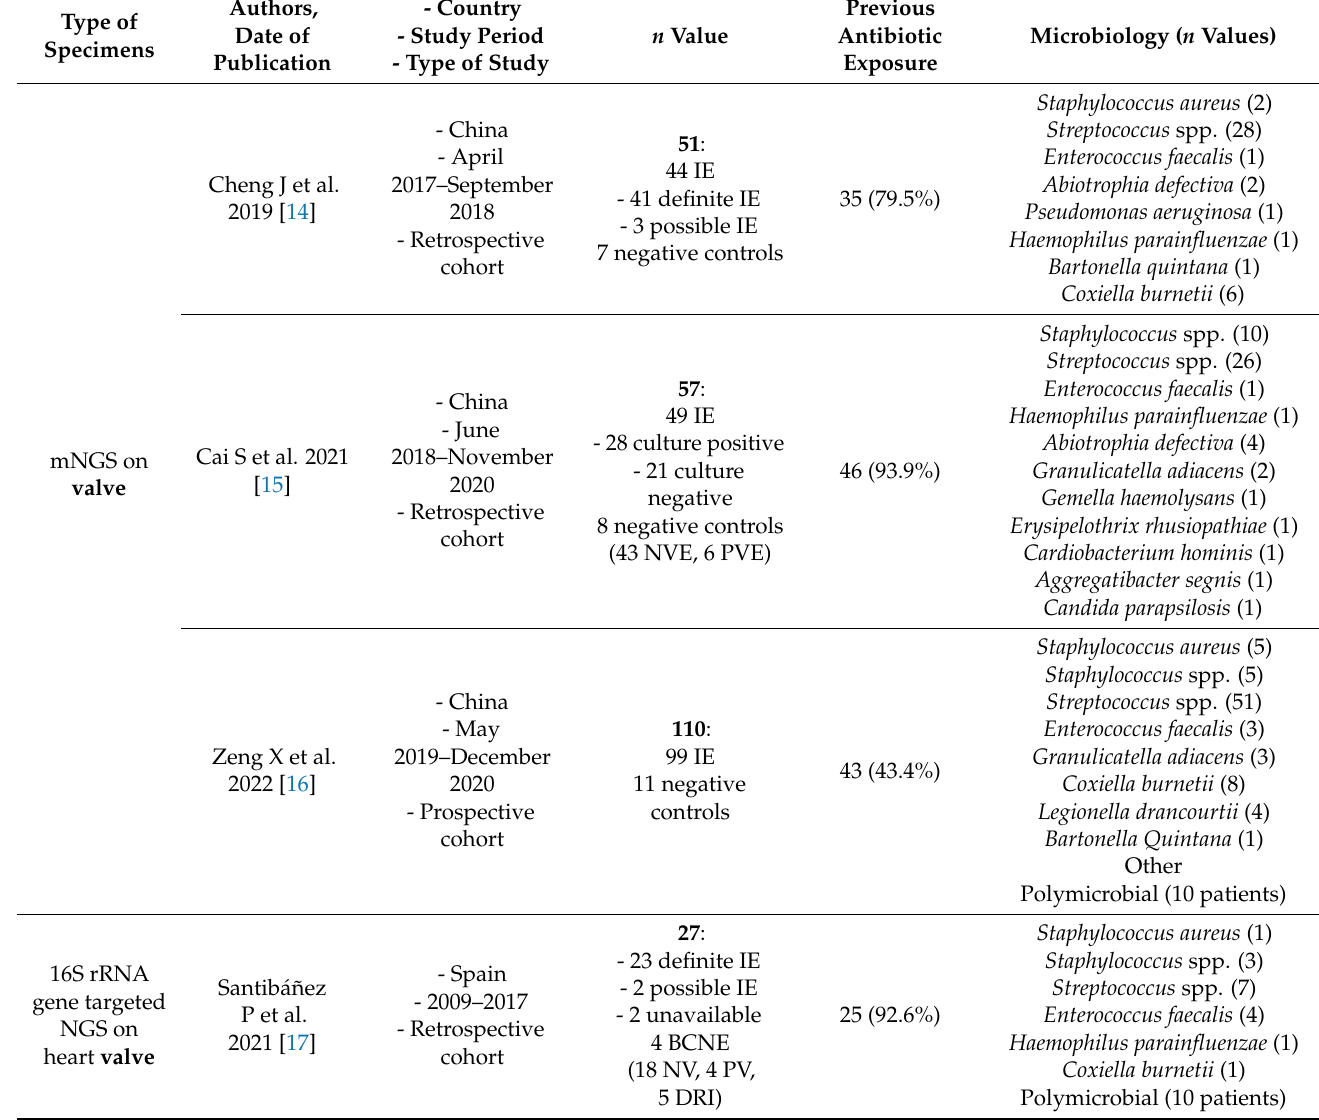
Table 1. The characteristics of the studies and identified